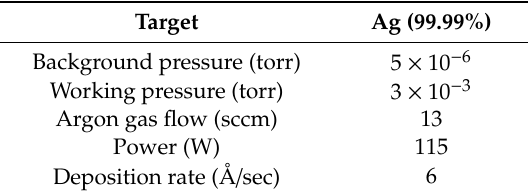
Table 1. The sputtering deposition parameters of silver film.